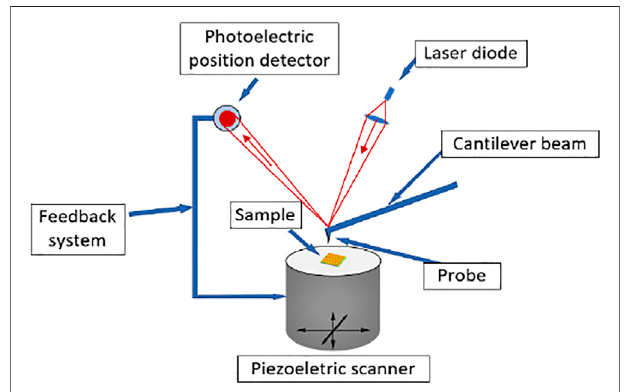
FIGURE 3 | Working principal diagram of atomic force microscope.